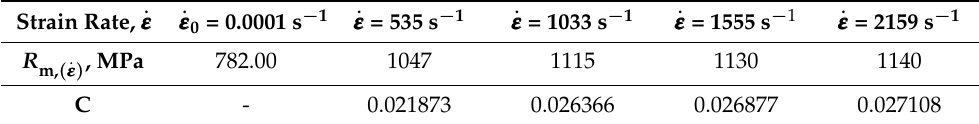
Table 3. Ultimate strength for various strain rates. . εεε Strain Rate,